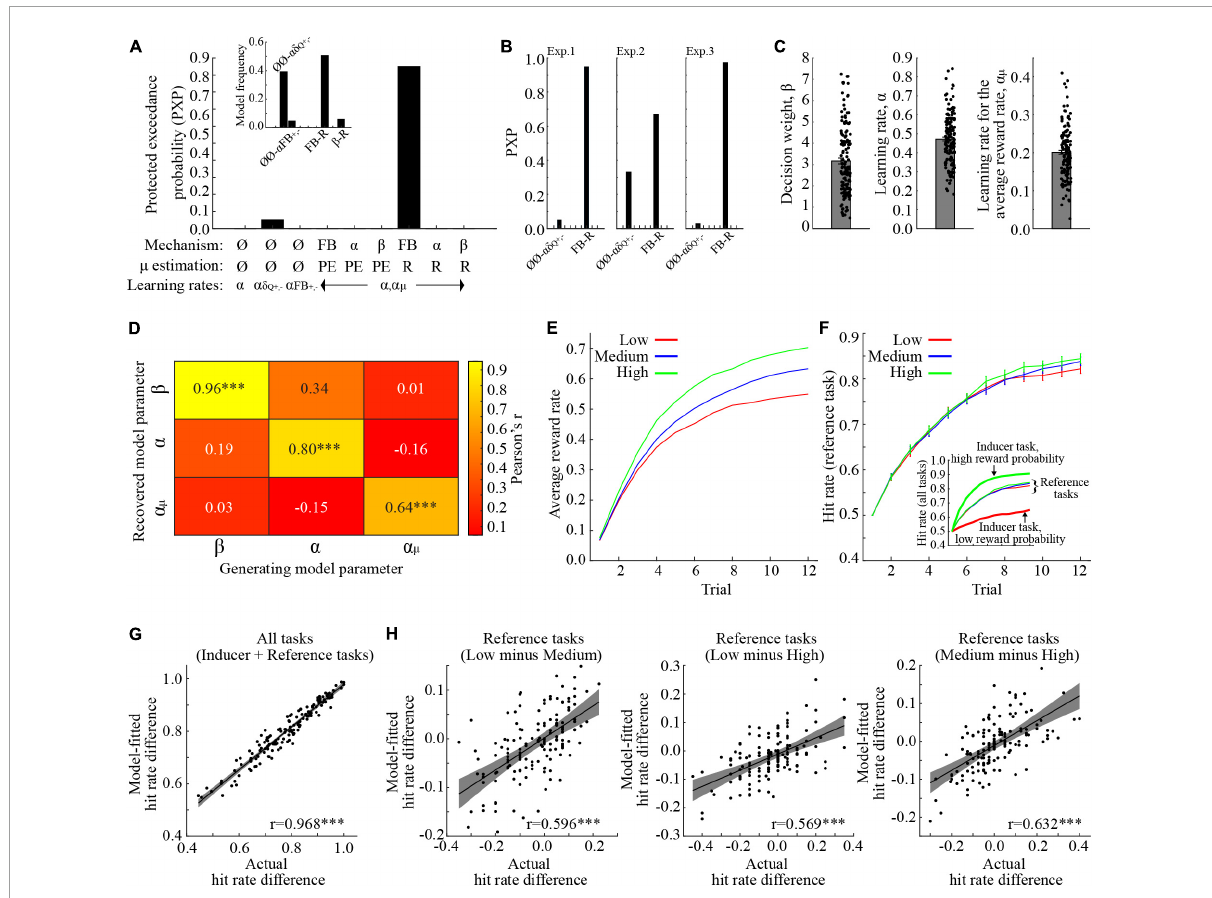
FIGURE2 Behavioral modeling. (A) Protected exceedance probabilities (PXP) when model parameters were fitted across all experiments. The highest PXP was obtained for the FB-R model, where the average reward feedback influences the prediction error component of the model. The inset shows the model frequencies. (B) PXP’s when model parameters were fitted in each experiment separately. In all experiments, the FB-R model had the highest PXP. (C) The model parameters, when fitted across experiments. (D) Correlation coefficients between model parameters used to generate behavior, and their recovered counterparts. (E) The average reward rate for the reference tasks in the different conditions. (F) Model-fitted hit rates for the reference tasks, collapsed across the three experiments. The inset also shows performance for the inducer tasks with low- and high reward probabilities. Inducer/reference tasks are, respectively denoted by bold / narrow lines. (G) Correlation between actual- and model-fitted learning performance, averaged across all conditions and tasks. (H) Correlations between actual- and model-fitted differences in learning performance for the reference task in the different conditions. ∗∗∗ p < 0.001. All error bars indicate the standard error of the